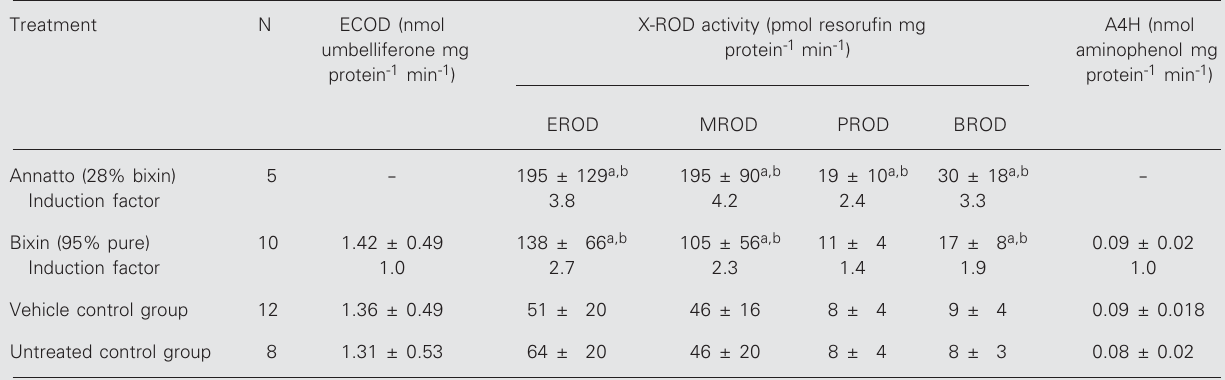
Table 1. Activities of 7-ethoxycoumarin- O -deethylase (ECOD), alcoxyresorufin- O -dealkylases (EROD, MROD, PROD and BROD) and aniline-4- hydroxylase (A4H) in liver microsomes from female Wistar rats treated orally with annatto (250 mg kg body weight -1 day -1 ), bixin (250 mg kg